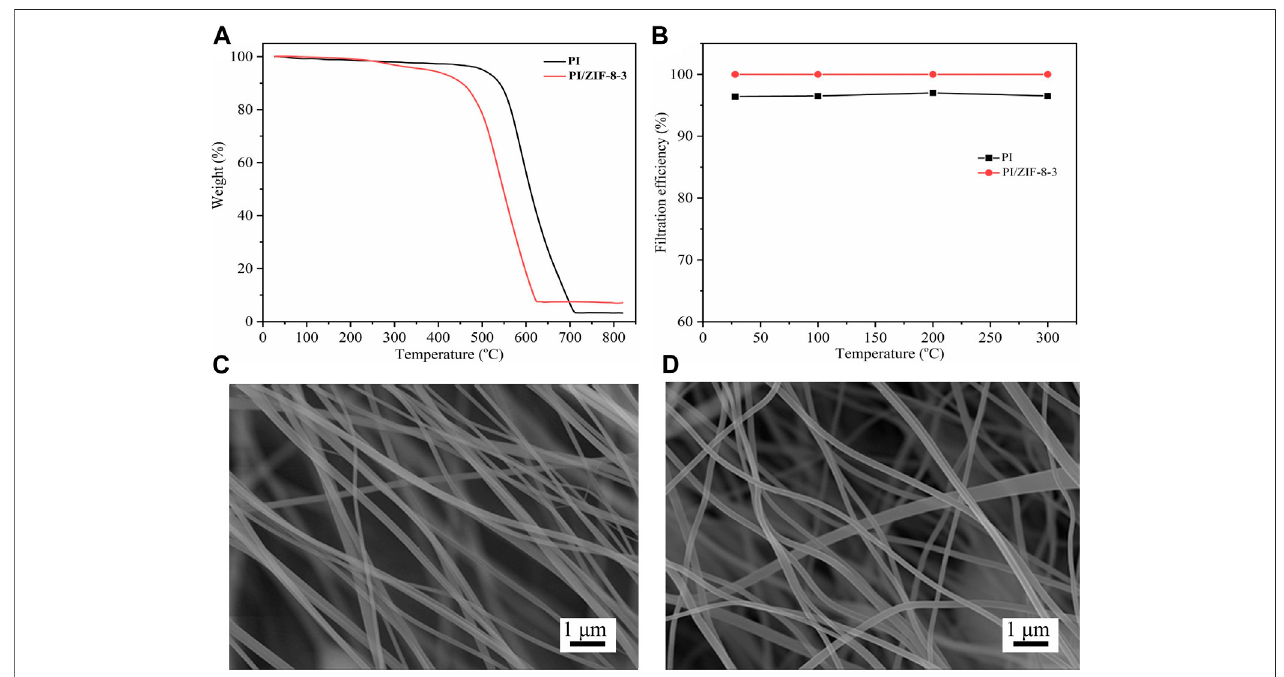
FIGURE5|(A) ThermogravimetriccurvesofPIandtheZIF-8-3/PImembranes. (B) Filtrationef fi ciencyofthePInano fi bermembranesandtheZIF-8-3/PInano fi ber membrane to PM 0.3 after being treated at different temperatures for 2 h. Scanning electron micrographs of the ZIF-8/PI nano fi ber membranes before (C) and after (D) heat treatment (300 °